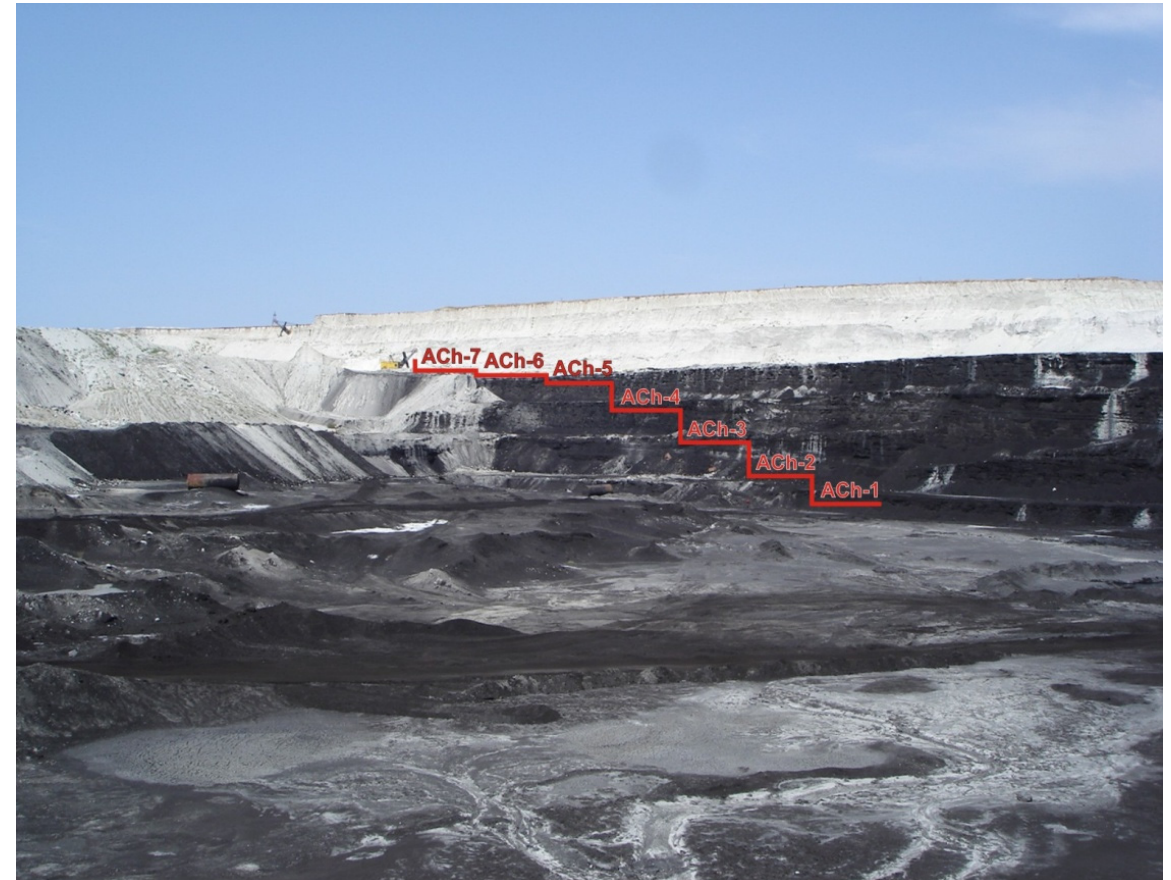
Figure 7. The sampling scheme in the Aduunchuluun coal mine (photo by Sergey Arbuzov).